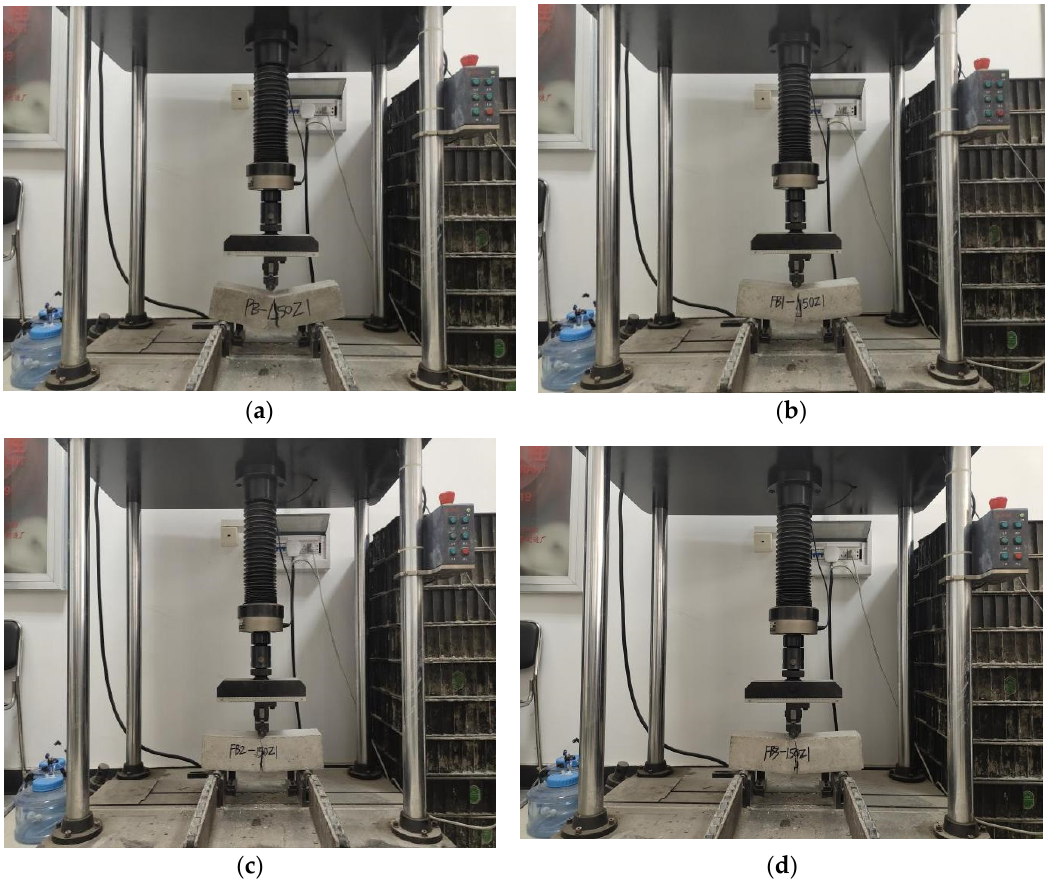
Figure 19. Flexural damage characteristics of the specimen. ( a ) Volume fraction of 0%. ( b ) Volume fraction of 0.1%. ( c ) Volume fraction of 0.2%. ( d ) Volume fraction of 0.3%.